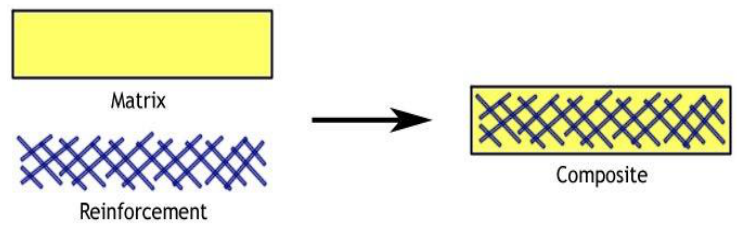
Figure 3. Composite material analogy.